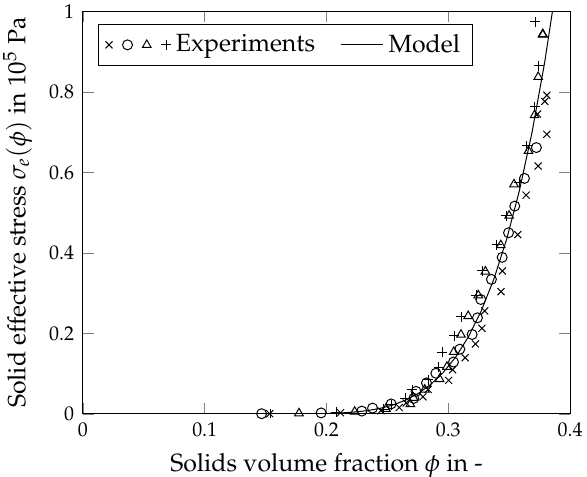
Figure 4. Compression resistance function: The experimental results and the adjustment (model) used for the simulation to describe the compression resistance in the sediment for the equilibrium state as a function of the solids volume fraction.